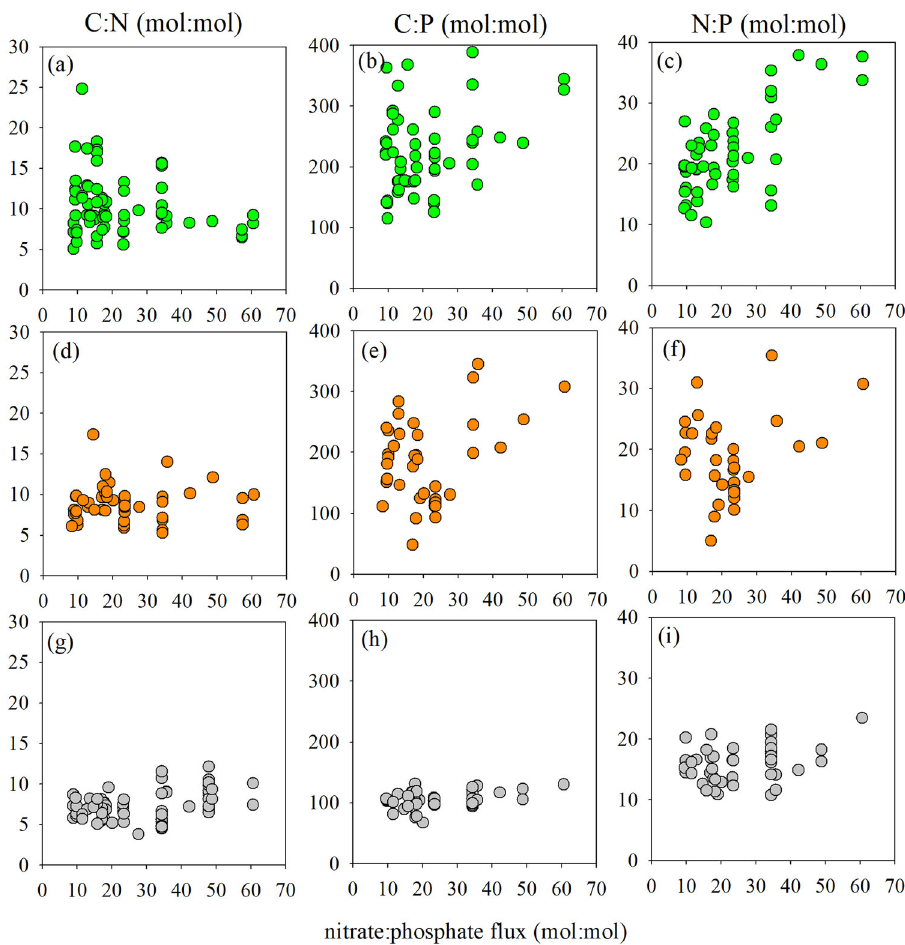
Fig. 4 Relationship of cellular stoichiometric ratios to vertical nitrate:phosphate fl uxes across the nutricline. ( a – c ) Prochlorococcus ; ( d – f ) Synechococcus ; and ( g – i ) Eukaryote populations and C:N ( a , d , g ), C:P ( b , e , h ), and N:P ( c , f , i ) ratios